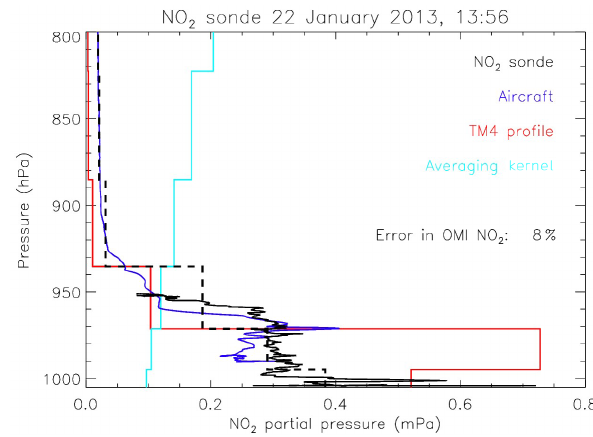
Figure 17. Comparison of NO 2 vertical profile obtained from KNMI NO 2 -sonde to in situ aircraft profile, TM4 model profile and OMI (DOMINO) averaging kernel for OMI pixel covering the DISCOVER-AQ site in Huron, California on 22 January